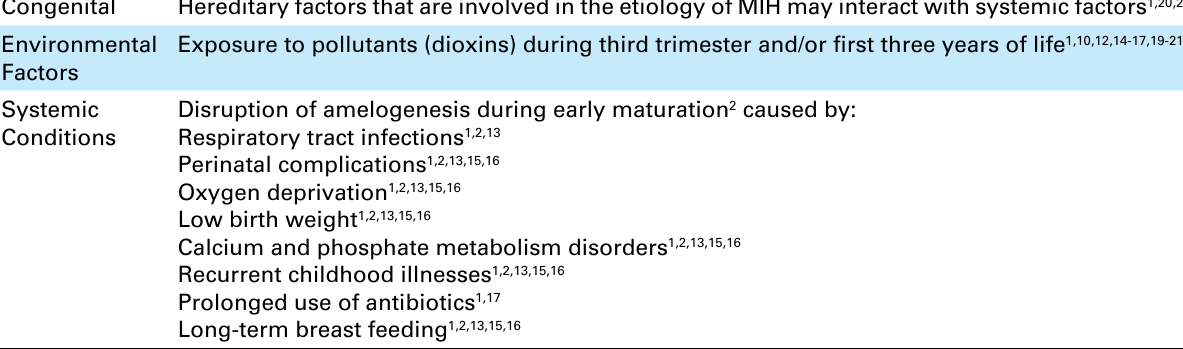
Table 1. Causes of Molar and Incisor hypomineralization. Congenital